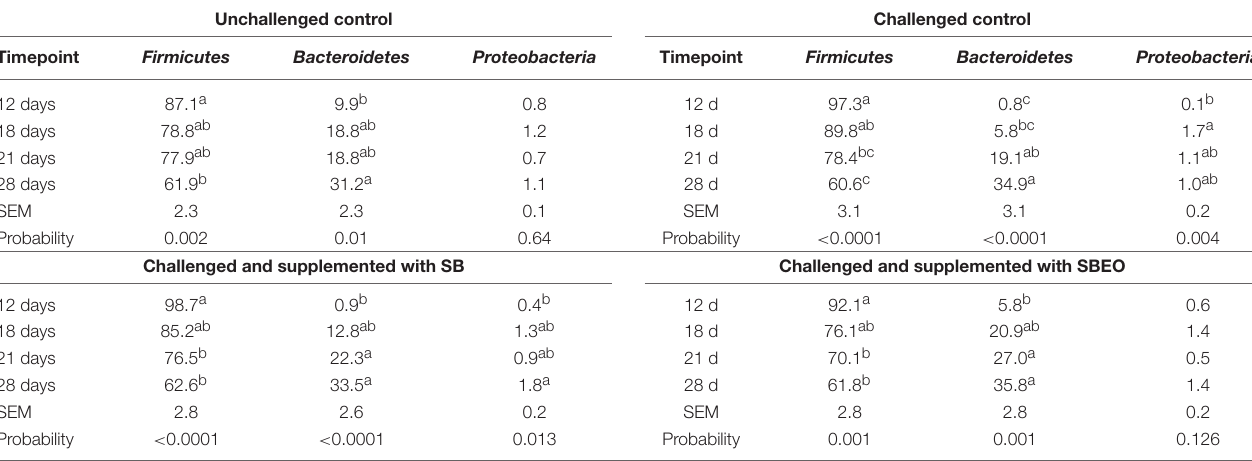
TABLE 5 | Relative abundance (%) of the main phylum in the cecal microbiota of broiler chickens at different timepoints whithin each one of the experimental